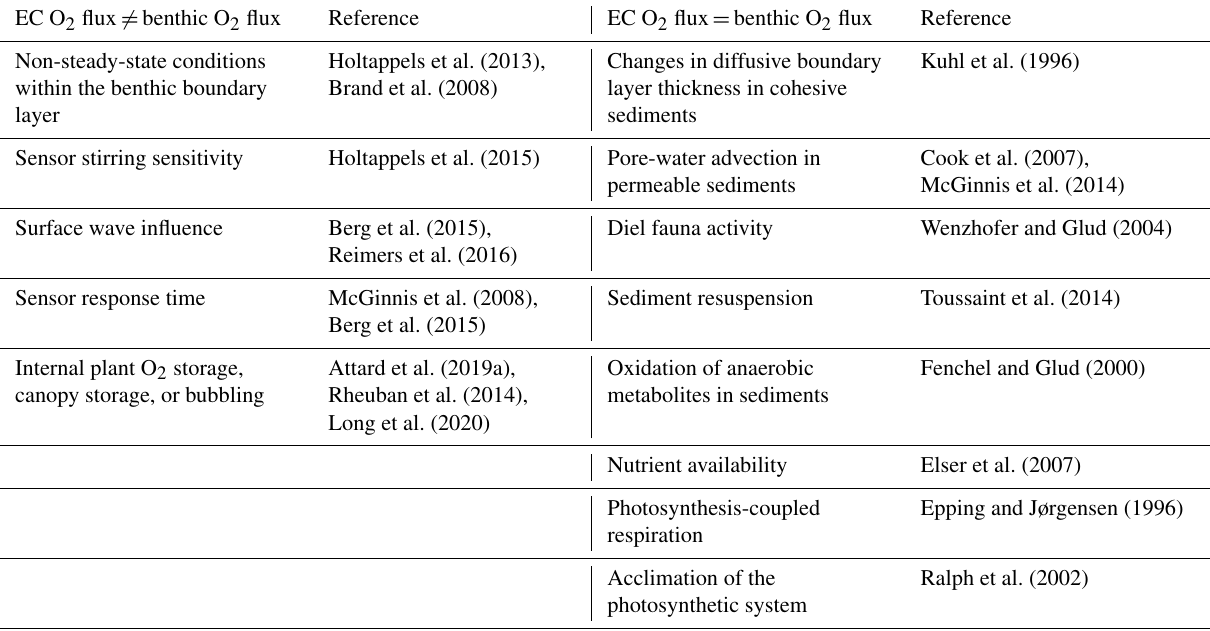
Table 1. Sources of EC flux variability can be broadly grouped into two categories: (1) sources that bias the measured EC flux away from the “true” benthic flux (i.e. when EC O 2 flux (cid:54)= benthic O 2 flux) and (2) “true” temporal variability in the benthic O 2 exchange rate (i.e.